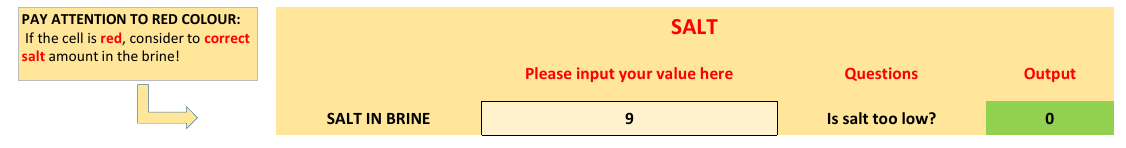
Figure 5. Section of spreadsheet for salt concentration in brine.